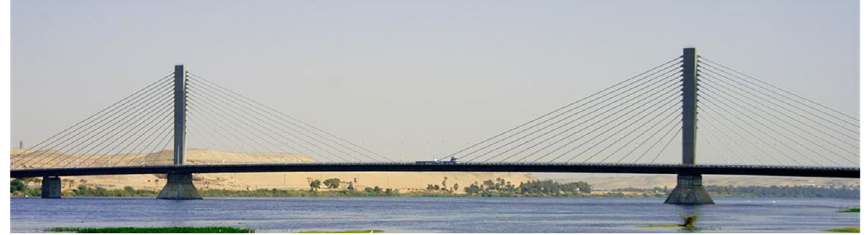
Fig. 1 Aswan cable‑stayed bridge (https:// struc turae. net/ en/ struc tures/ aswan‑